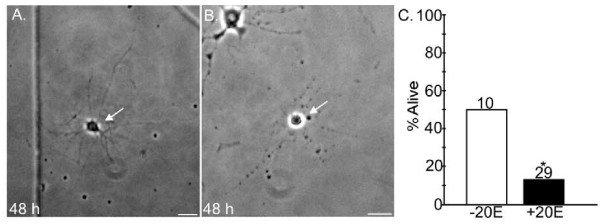
Cell contact does not regulate putative RP2 fate in culture. (A, B) Low-power photomicrographs show contact-free putative RP2s after 48 h in culture, in the absence (A) or presence (B) of 20E. The putative RP2 in (A) is alive and that in (B) is dead. Note absence of neuritic contact with other neurons. (C) Histogram shows percentage of putative RP2s alive at 48 or 72 h (data pooled from Figures 7 and 8); n given above each bar. Among these contact-free putative RP2s, significantly fewer survived in cultures containing 20E (*P = 0.028; Fisher's exact test). Scale bar: 10 μm.